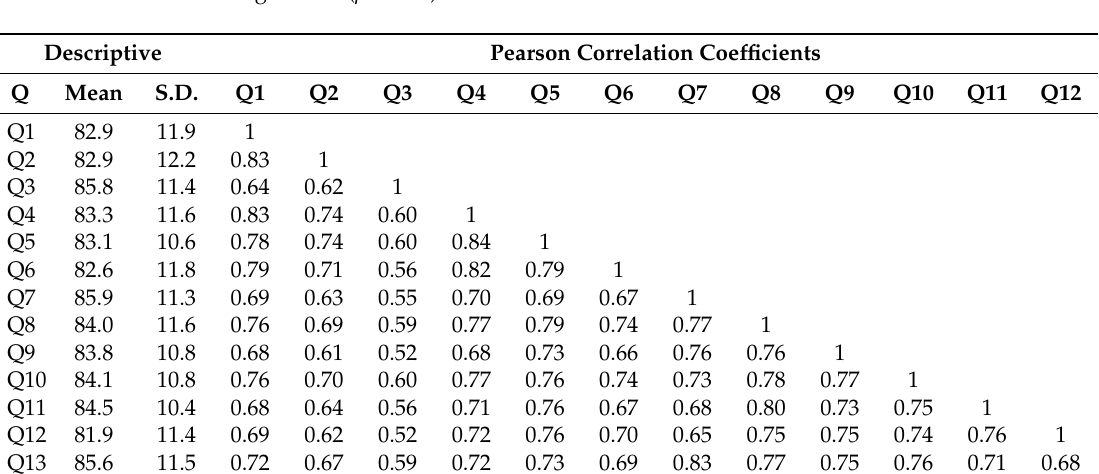
Table 3. Mean and Standard Deviation of each item’s ratings, and Pearson correlations between items. All correlations are significant ( p < 0.01) and each item has 2228